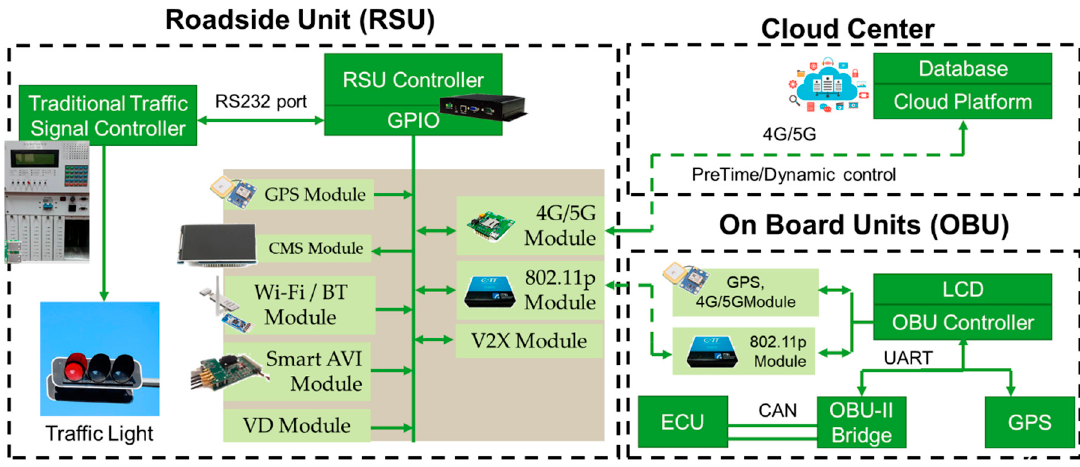
Figure 1. System architecture of the STSC system.